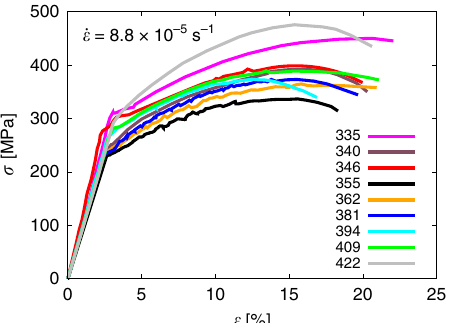
Fig. 1 Serrated fl ow occurs in engineering alloys in speci fi c temperature- strain rate windows. Deformation curves for Nb-0.75% at. O at fi xed strain rate varying the temperature, displaying transitions from-smooth to serrated fl ow (adapted from ref. 15